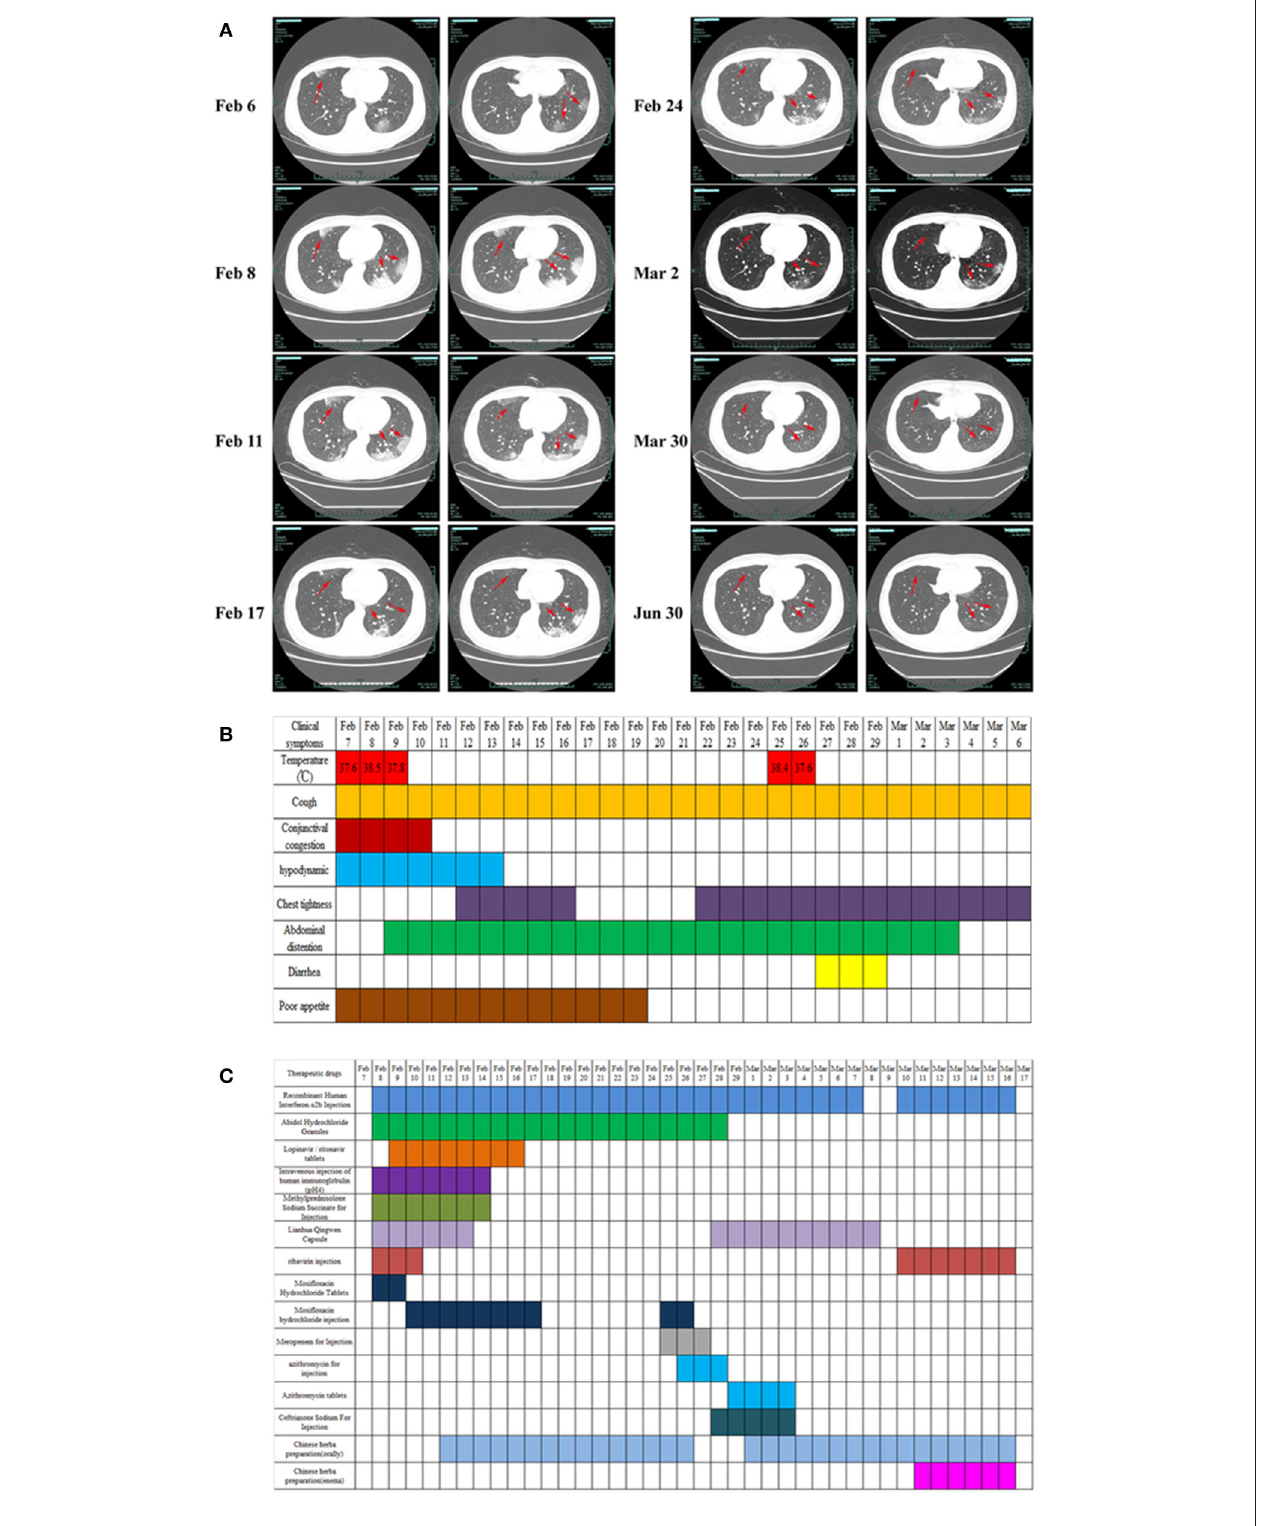
FIGURE 1 | Clinical imaging, symptoms, and drug treatment data of patients with COVID-19. (A) CT image changes of patients with COVID-19 from first visit to discharge. (B) Changes in clinical symptoms in patients with COVID-19 during treatment after admission. (C) Medication information for patients with